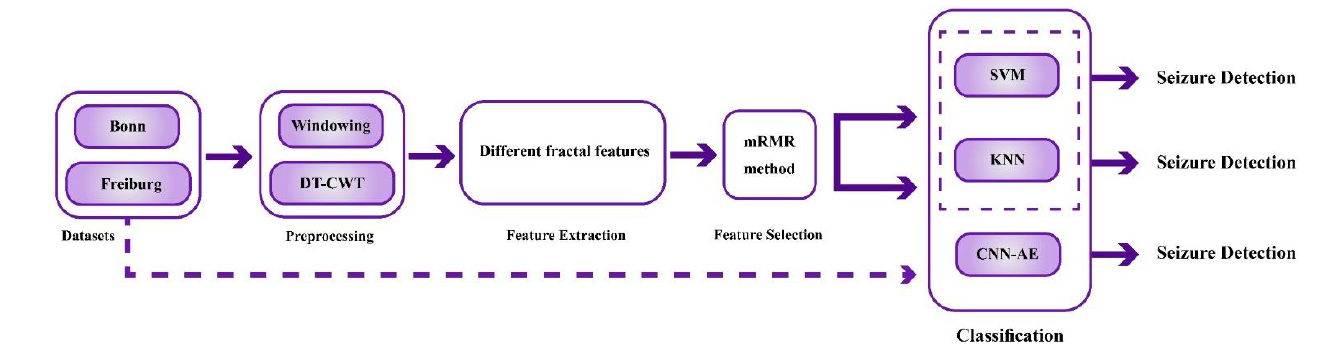
Figure 1. The block diagram of proposed method for epileptic seizure